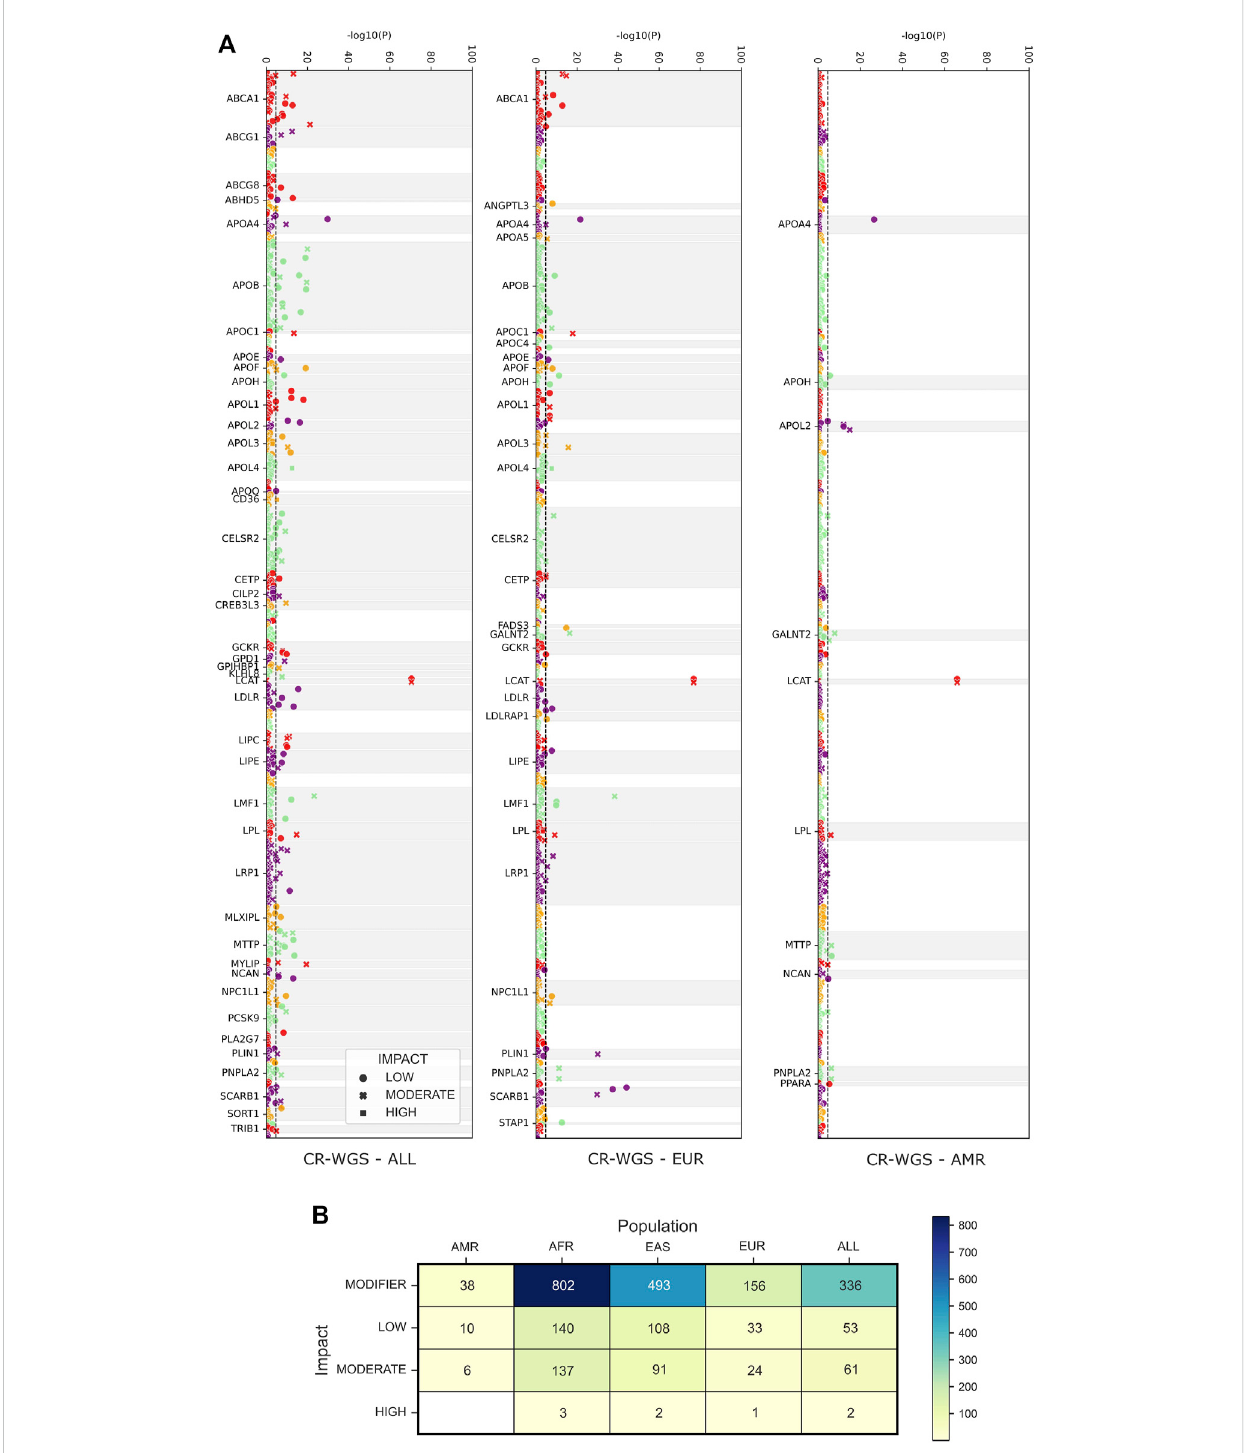
FIGURE 6 ObserveddifferencesbetweenallelicfrequenciesingenesassociatedwithlipidmetabolisminCostaRicanscomparedtothosereportedin1KGP. (A) Probability, according to Fisher ’ s test, that the polymorphic sites have differences in their allele frequencies. The dotted line marks the signi fi cance threshold with the Bonferroni fi t. Variants are categorized as LOW, MODERATE, and HIGH by VEP. (B) The number of variants with allelic frequencies signi fi cantly different from those observed in the Costa Rican cohort studied. CR-WGS: Costa Rican genomes evaluated in this study, ALL: all Subjects from 1KGP phase 3, EAS: East Asia, EUR: Europe, AFR: Africa, AMR: Latin